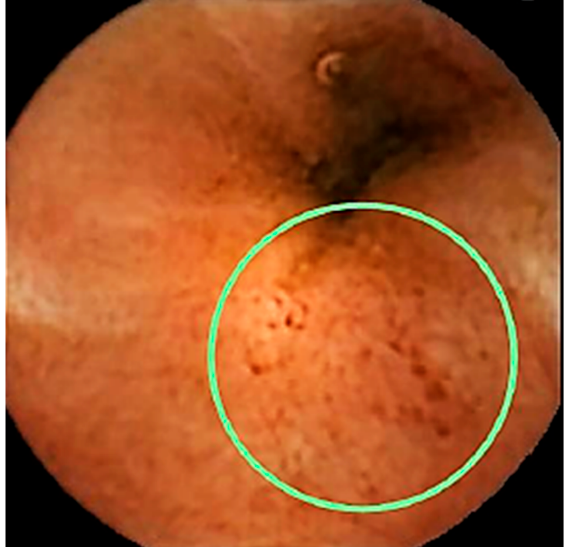
Figure 3. Capsule endoscopy image of a FDR enrolled in the screening study [49]. The circle shows an area of inflammation and small ulcers in the ileum.